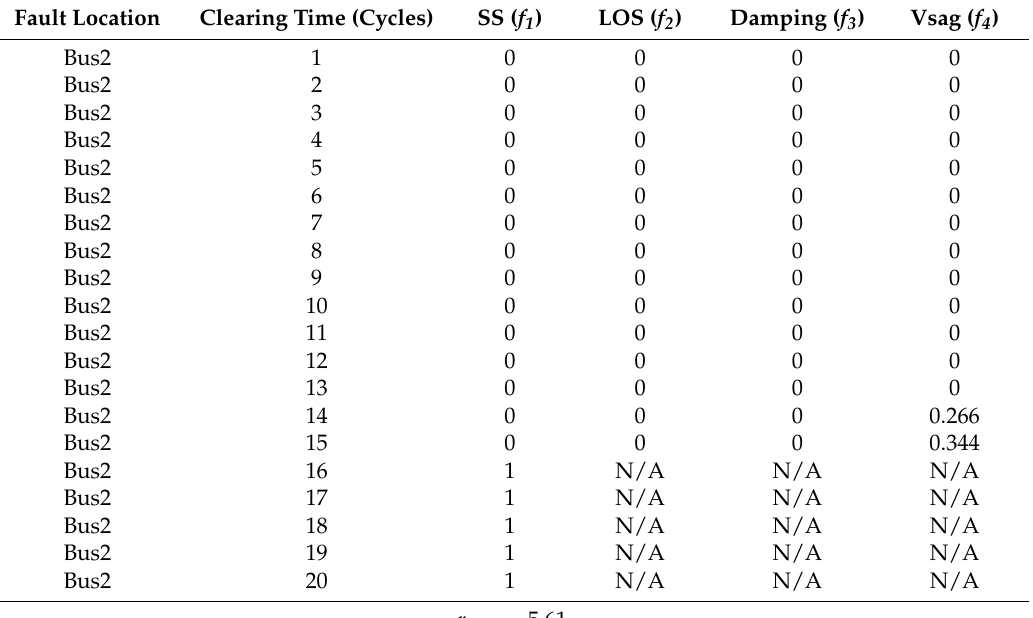
Table 2. Simulation results at bus 2 for dispatch D 0